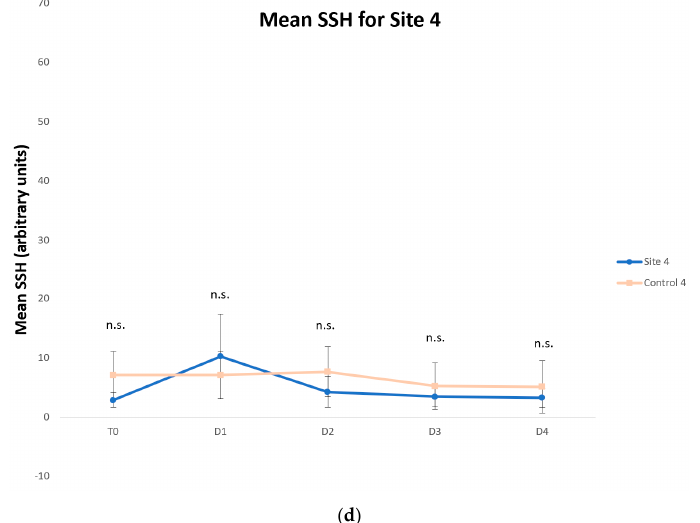
Figure 4. Means and standard deviations of skin surface hydration (SSH) for Site 1 (Week 1) ( a ), Site 2 (Week 2) ( b ), Site 3 (Week 3) ( c ) and Site 4 (Week 4) ( d ). Days were labeled as T0 (before tape stripping), D1 (one hour after tape stripping), D2 (24 h after tape stripping), D3 (48 h after tape stripping) and D4 (72 h after tape stripping). The values increased for test sites after tape stripping and decreased towards control values on the following days (n.s., not significantly different from control). The mean SSH values on D1 did not significantly decrease in Site 2 or Site 3 compared with Site 1, but they were significantly reduced in Site 4 compared with Site 1 ( p = 0.035, Figure 5). This result correlated with the TEWL values.